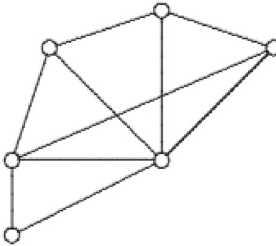
Fig. 8 The graph G n − 5 obtained after folding W n n − 5